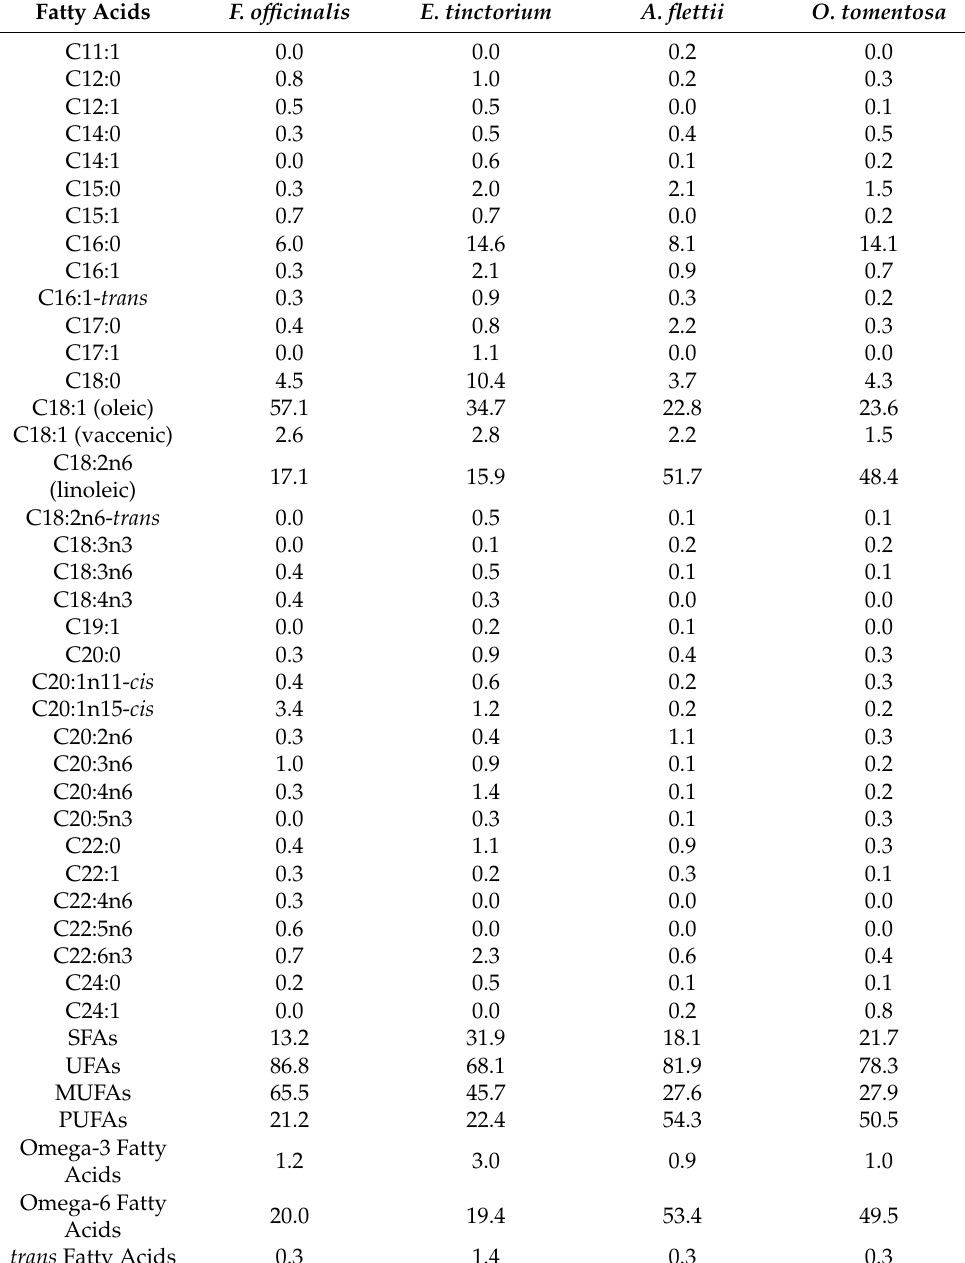
(Table 2) and micrograms of fatty acids determined per gram of dried mushroom samples ( µ g/g) (Table S2). Table 2. Fatty acid composition in four selected mushrooms (%). Fatty